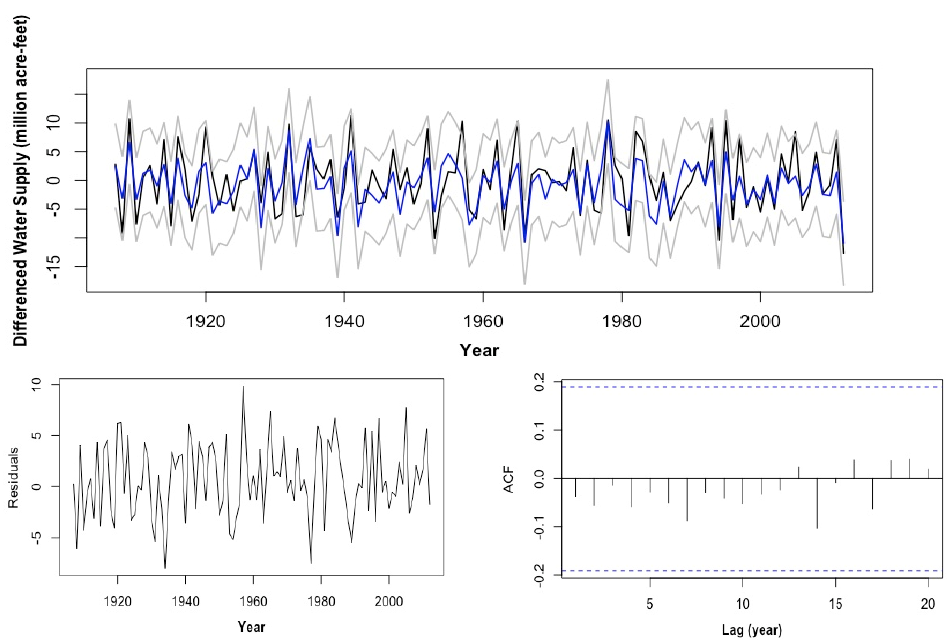
Figure 8. Diagnosis plots of the ARMAX (19,1,2,0) model: (top) overlaid plot of the observed annual water supply anomaly (cid:1850) (cid:3047) (black), model fitted value (blue) and its 95% confidence interval (grey); (left) residual plot; (right) ACF of the residual.